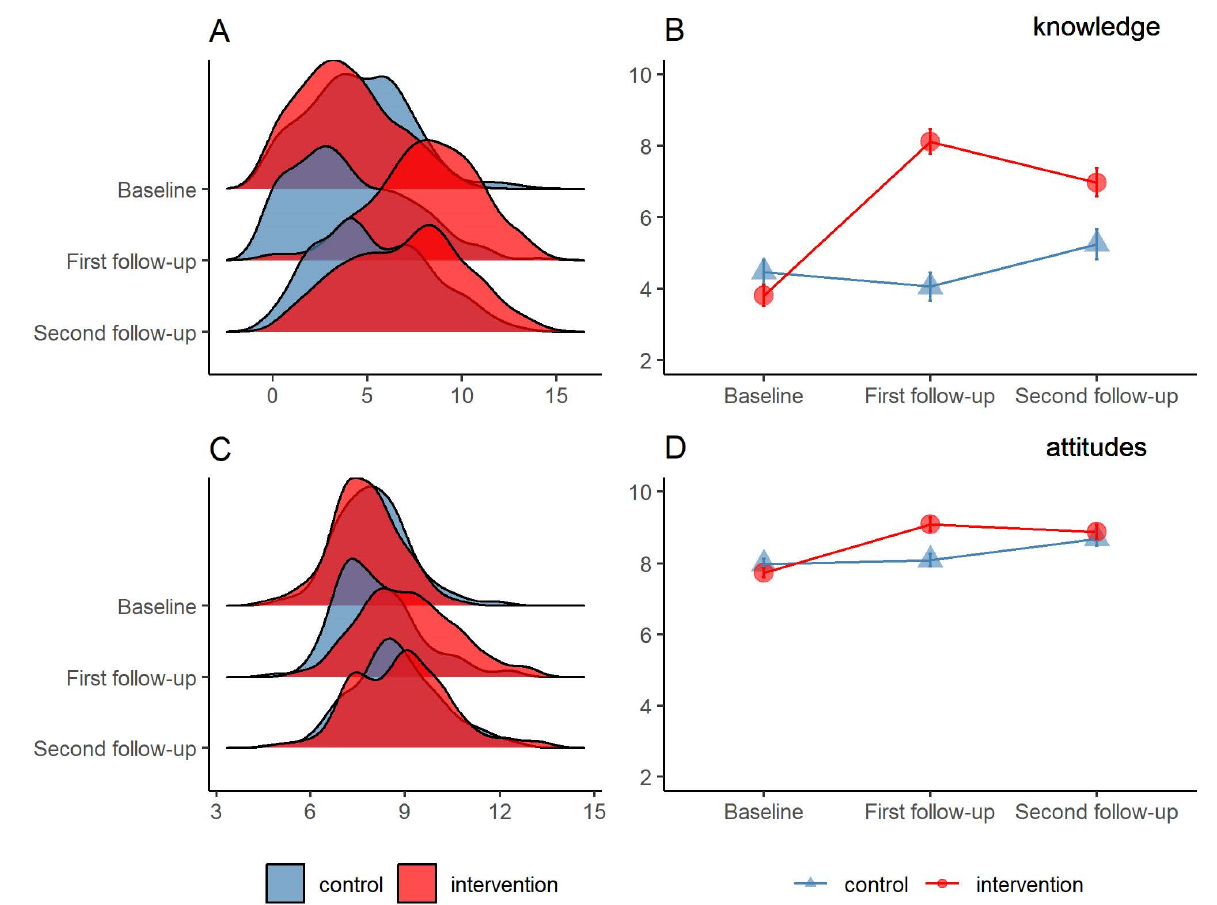
Figure 2. Student’s sexual knowledge and attitudes score in three rounds of surveys by intervention arm (N = 501). ( A )The ridge plot comparing sexual knowledge score distribution among baseline and the following two follow-up tests; ( B ) The line plot comparing the mean of sexual knowledge score with 95% confidence interval; ( C ) the ridge plot comparing sexual attitudes score distribution among baseline and the following two follow-up tests; and ( D ) The line plot comparing the mean of sexual attitudes score with 95% confidence interval. Table 3. Estimated curriculum’s effect on sexual knowledge and attitudes a ( n =